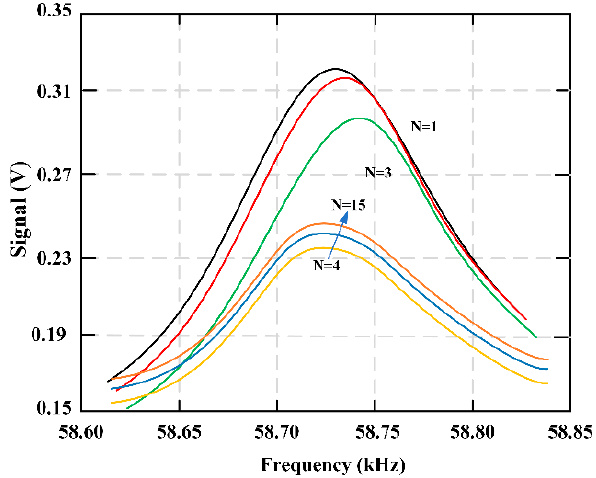
Figure 17. The fibrinolysis of the partially formed fibrin clot, and with the addition of plasmin, the viscosity still increases for a few seconds.